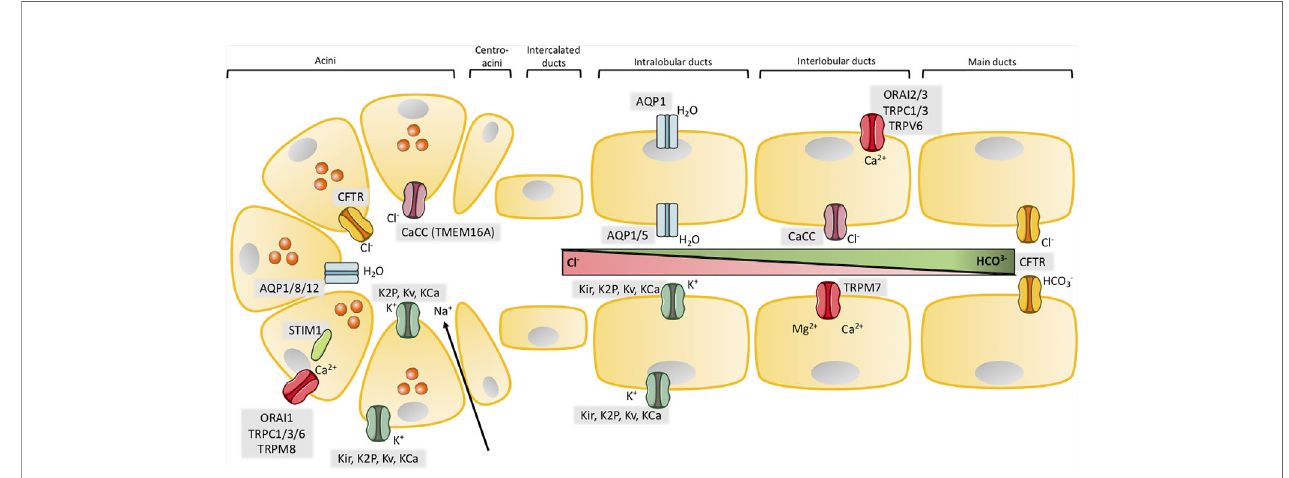
FIGURE 1 | Ion channels in exocrine pancreas. Illustration of the structure of acinar and major ductal segments of secretory glands in pancreas. Acinar cells secrete digestive enzymes (orange circles in acini) and an isotonic NaCl rich fl uid which transports the enzymes to the ducts. Fluid secretion in acini cells is regulated by a Cl - secretion process. Cl - secretion is activated by [Ca 2+ ] i , from a Ca 2+ in fl ux through SOCs in the basolateral membrane, where Cl - channels, Ca 2+ activated Cl - channels (CaCC) and different types of K + channels are activated to provide the ef fl ux of their respected ions. K + channels also create a driving force by maintaining a negative membrane potential. The negative charge mediated by a high concentration of Cl - ions results in transport of Na + through tight junctions to the luminal space. NaCl makes the driving force for water to ef fl ux through aquaporins and a cell shrinkage. This cell shrinkage reduces [Ca 2+ ] i , which inhibits Cl - and K + ef fl ux through their channels and in parallel activates basolateral transporters and pumps to restore both Cl - and K + . The digestive enzymes are transported in the NaCl isotonic fl uid to the ducts, which is low in HCO 3- concentration in the proximal ducts, but this concentration increases through the transport to the distal duct cells. The ductal fl uid becomes rich in HCO 3- , by a two-step process. The fi rst step takes place in the proximal ducts, where Cl - /HCO 3- exchangers secretes HCO 3- and absorb Cl - and Cl - channels recycle Cl - . As in the acinar cells an osmotic reaction happens, where ef fl ux of negative HCO 3- and Na + drives water fl ow through aquaporins. This results in high concentration of HCO 3- (~100 mM), a low concentration of Cl - (~25 mM) and a high fraction of water in the pancreatic juice. The second step takes place in the distal part of the ducts, where the speci fi c Cl - channel CFTR changes selectivity to HCO 3- and function as a HCO 3- ef fl ux channel to determine the fi nal concentration of the HCO 3- rich fl uid (~140 mM). K + channels may, as in acini, take part in the secretion of K + and regulation of anion transport by maintaining the membrane potential in both the basolateral and luminal membrane. SOCs ensure the in fl ux of Ca 2+ which takes part in regulation of ion channels through [Ca 2+ ] i as in acini. Activation or inhibition of P2 receptors by Ca 2+ signaling also regulate anion secretion through K + and Cl - channels.